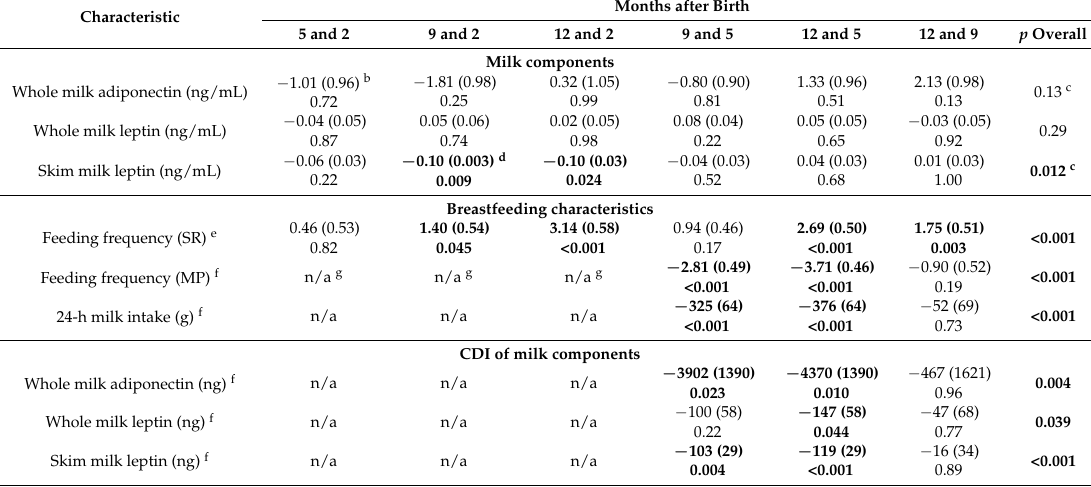
Table 3. Differences by infant age/lactation duration within measured human milk adipokines and breastfeeding parameters a